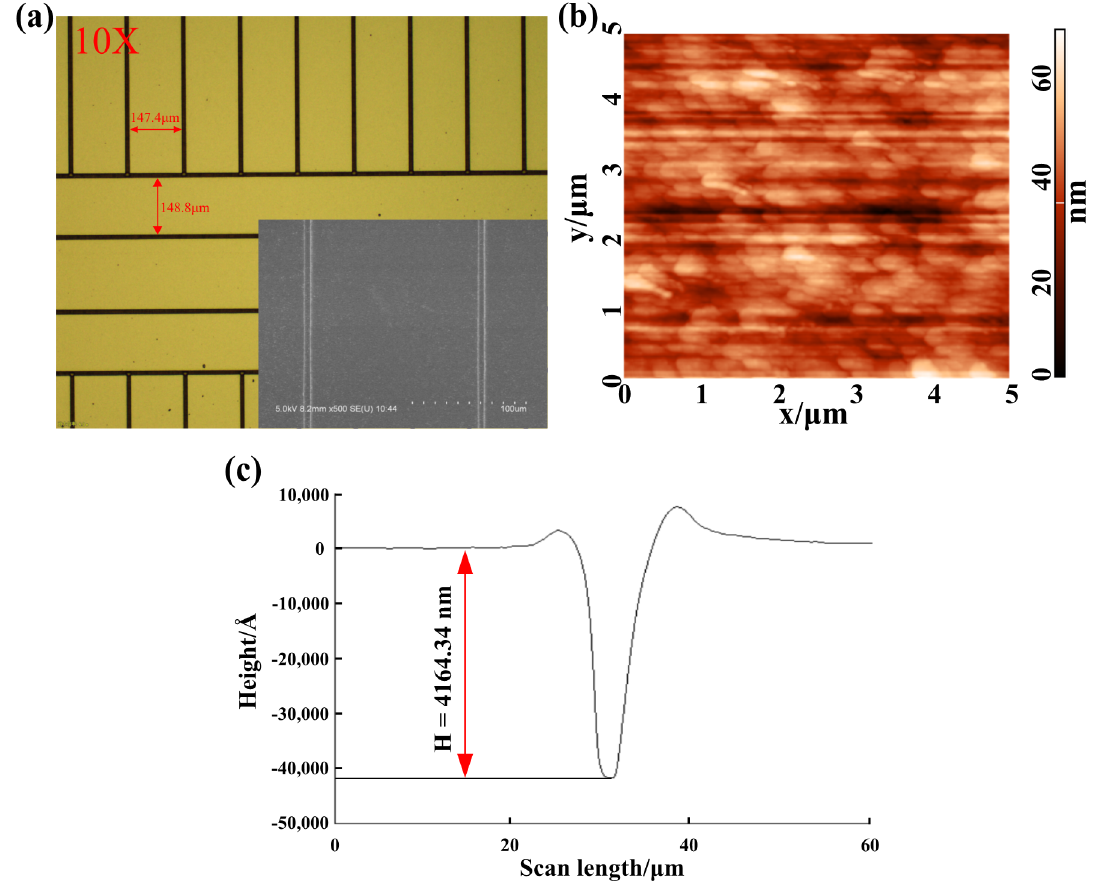
Figure 7. ( a ) Overall surface of thick film SEIT, the illustration is a SEM image; ( b ) The Ra is 6.2 nm which is characterized by AFM; ( c ) The thickness of the electrode is 4.16 μm which is measured by a-step device.